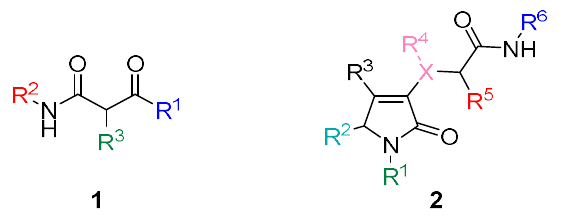
Figure 1. General structures of two type of structures tested in gelification